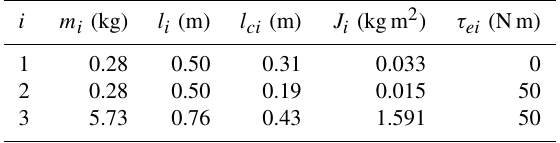
Table 1. The parameters of the control